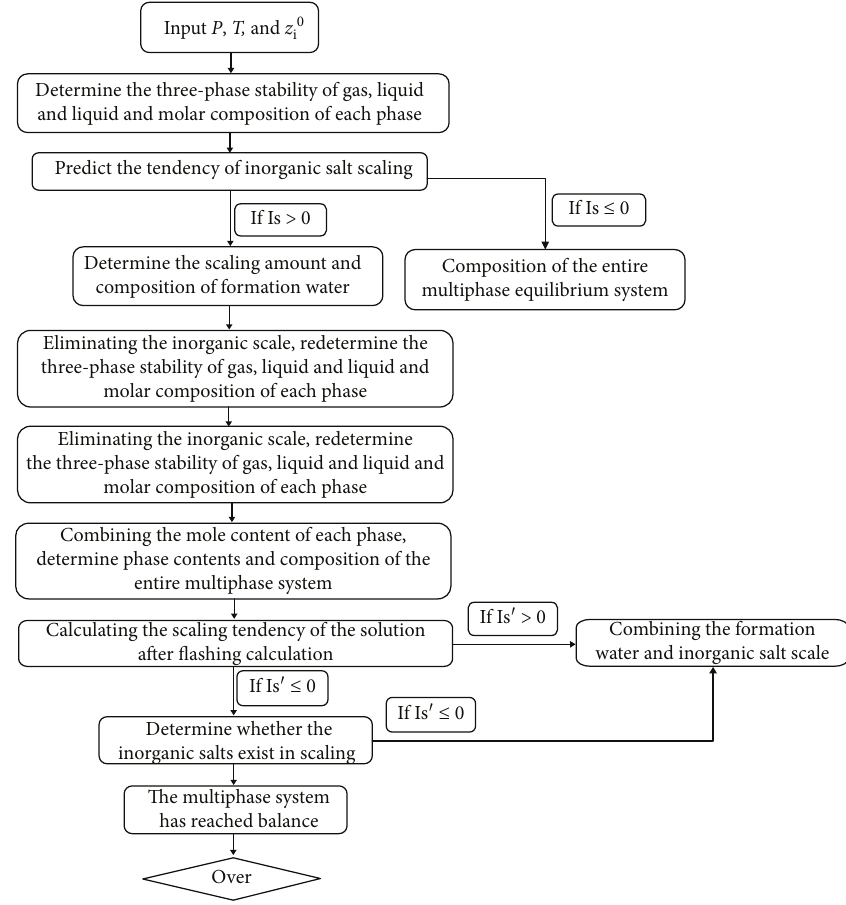
Figure 6: Flow chart of gas-liquid-liquid-solid multiphase equilibrium scale prediction. Table 4: Composition of injection